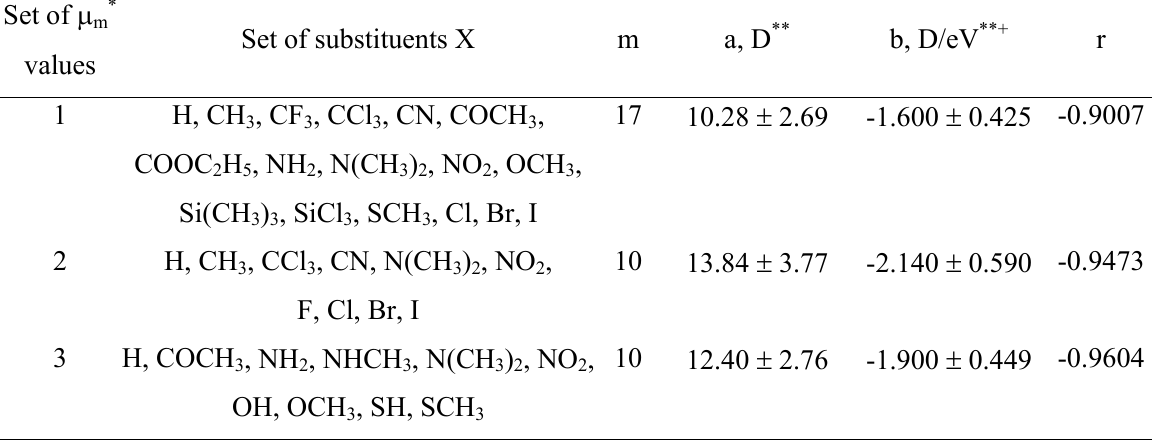
Table 5a. Correlations of mesomeric dipole moments of X substituents with electron affinity (A) H N + ≡ N values for 4-XC 6 4